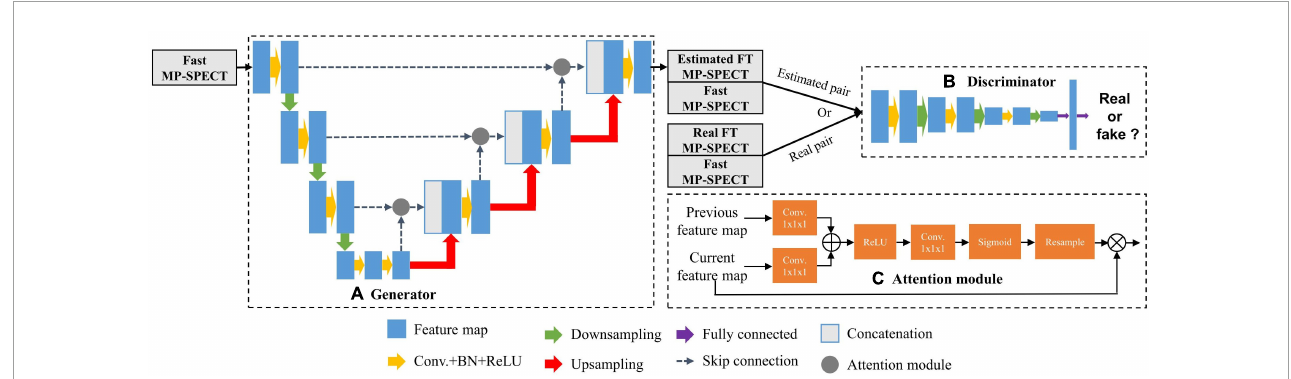
FIGURE1 The AttGAN architecture used in this study. (A) Generator; (B) discriminator; (C) attention module.